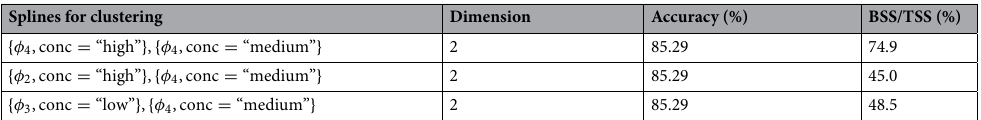
Table 3. The accuracy rate and between to total sum of squares ratio for k-means clustering after variable selection for three different choices of selected variables.